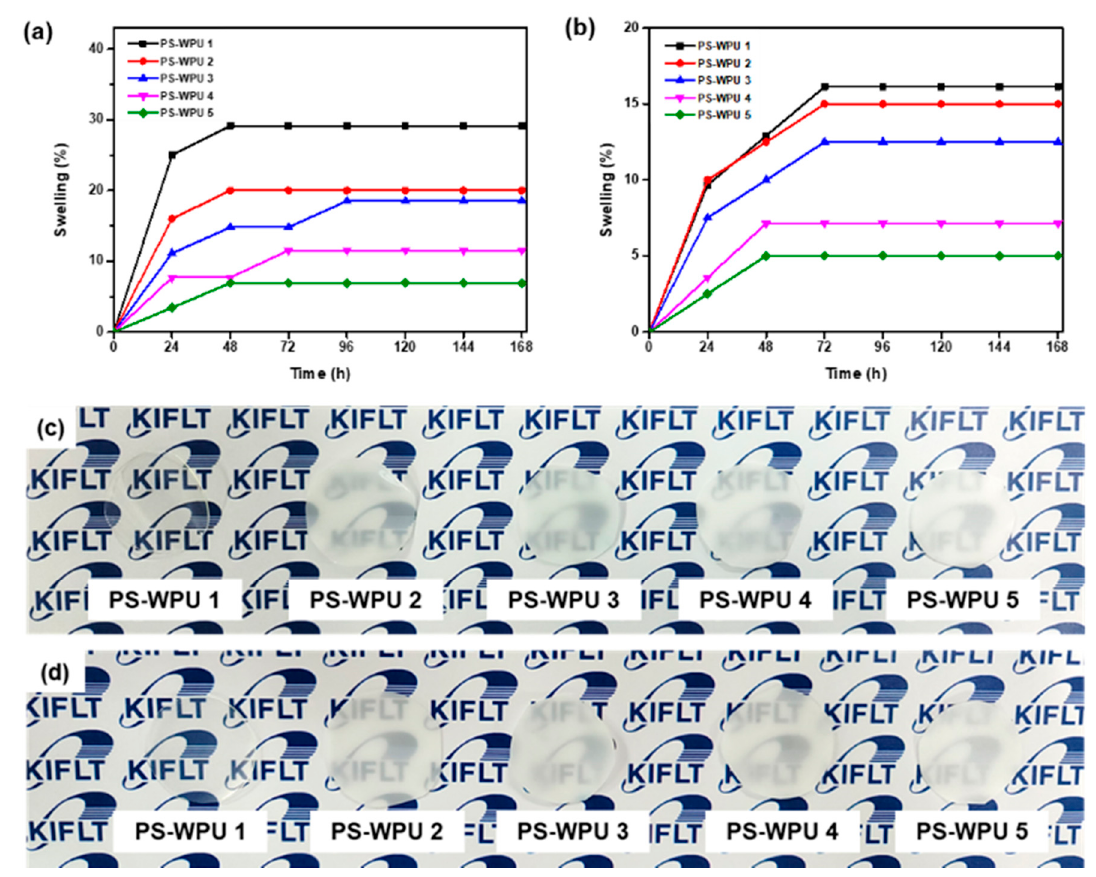
Figure 9. Water swelling ratio of the PS-WPU samples in ( a ) D.W and ( b ) S.W Images of the PS-WPU samples ( c ) before and ( d ) after swelling in D.W.